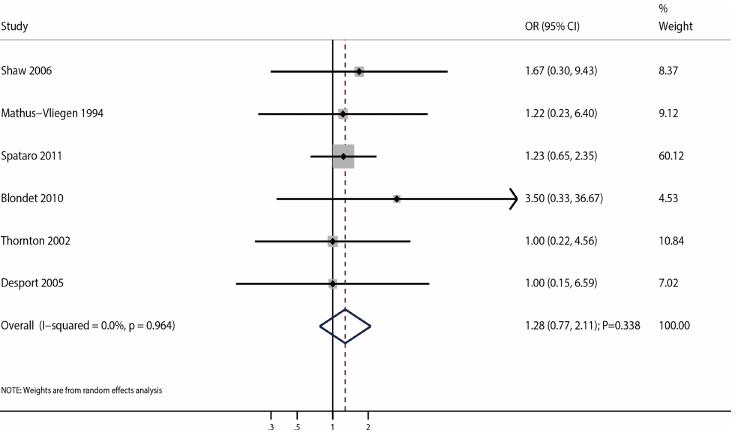
Fig 5. Association of PEG use and 30-month survival